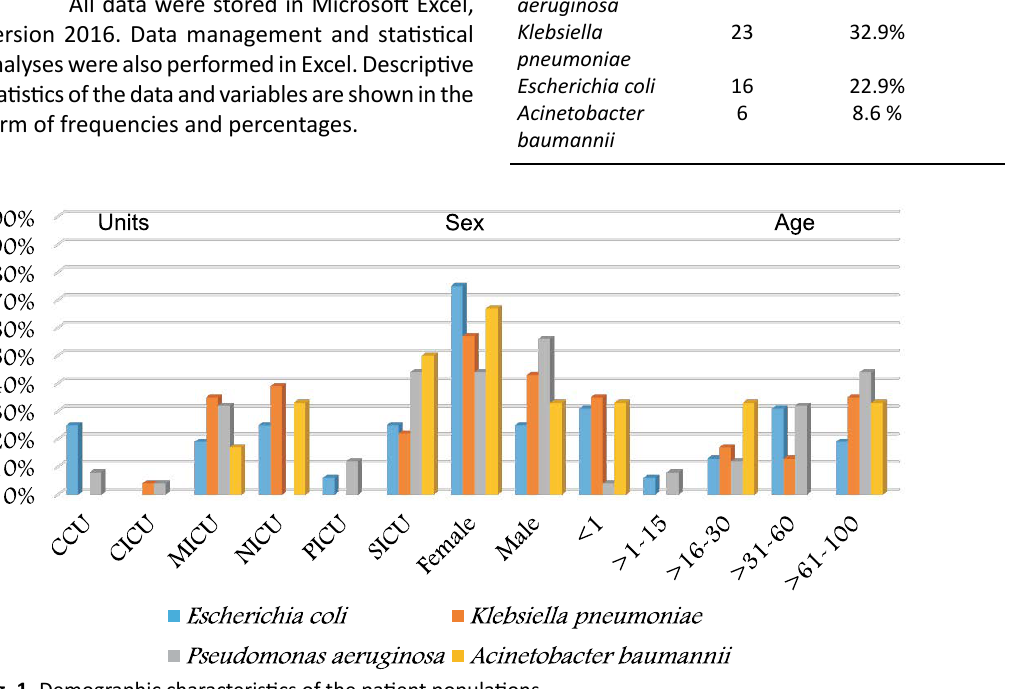
Fig. 1. Demographic characteristics of the patient